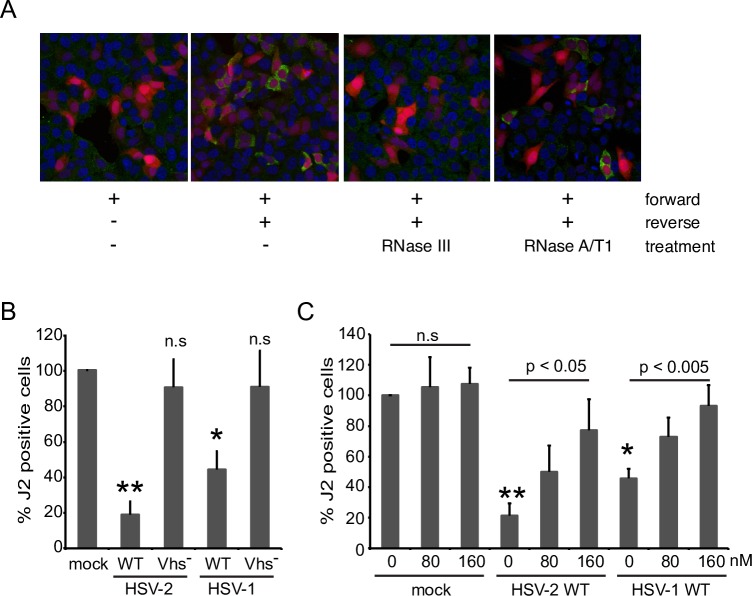
Reduction of preformed dsRNA by virion-derived vhs is sensitive to hippuristanol.A) HeLa cells were transfected with fwd or fwd/rev for 20 hours. Cells were then mock treated or treated with RNaseIII or RNaseA/T1 (high salt buffer) and analyzed by immunofluorescence with the dsRNA-specific antibody J2 (green). B) HeLa cells were transfected with fwd/rev for 20 hours and mock infected or infected with HSV-1 (KOS) and HSV-2 WT and Vhs- at an MOI of 20 for 5 hours in the continuous presence of actinomycin D. After immunofluorescence staining with the J2 antibody the ratio of J2 positive cells was determined by analyzing more than 100 mCherry-positive cells per coverslip. The ratio of J2 positive to mCherry positive cells in the mock infected sample was set as 100%. The graph represents the average of 4 independent experiments. P-value vs. mock: * p<0.005, ** p< 0.0005; ns: nonsignificant; C) Hippuristanol (hip) antagonizes the dsRNA-destabilizing effect of vhs. The experiment was performed as described in B) with addition of vehicle control (0nM) or hip at 80 or 160nM during the course of infection. The graph represents the average of 4 independent experiments. P-values WT 0nM hip vs. mock 0nM hip: * p<0.005, ** p<0.0005; p-value 160nM hip vs. 0nM hip: p<0.05 (HSV-2), p<0.005 (HSV-1).